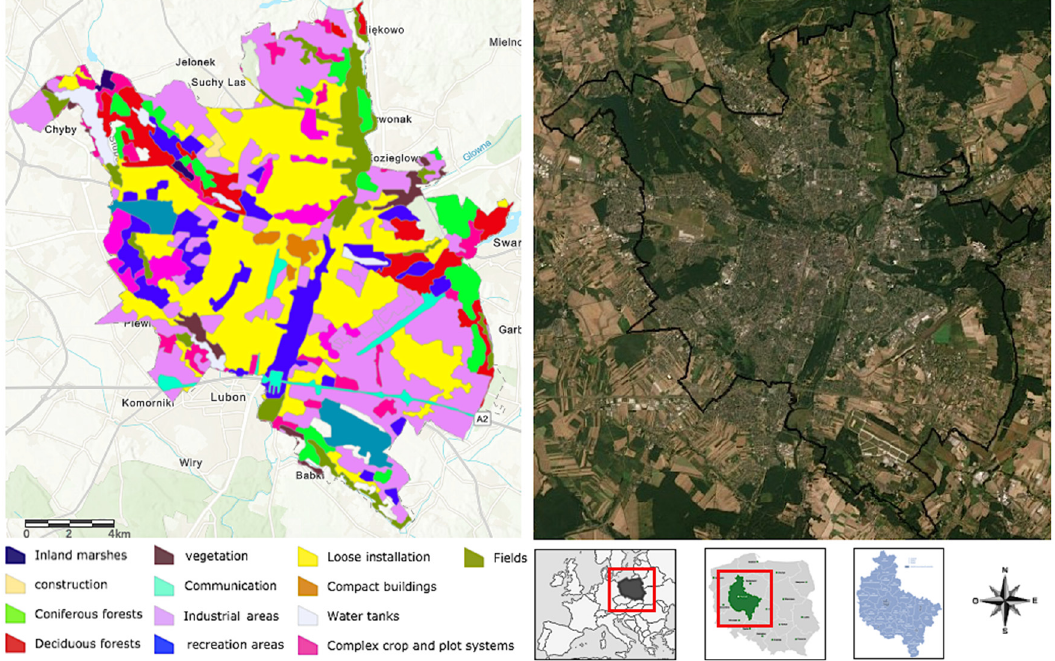
Figure 3. Location of the study area (Pozna ń ), classification established by CORINE Land Cover and the high resolution aerial image selected. Source: https://www.arcgis.com/apps/webappviewer.